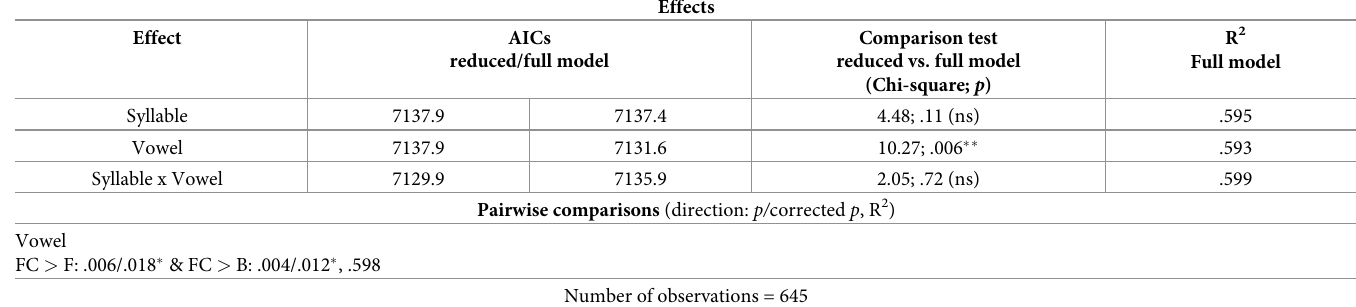
Table 3. Effects on F 1 (in Hz) at the midpoint of the steady state. Local effect size measures such as partial eta-squared do not apply to linear mixed effects models [76]. R 2 measures may be used instead as whole-model effect sizes for the purpose of comparison and meta-analysis [77].